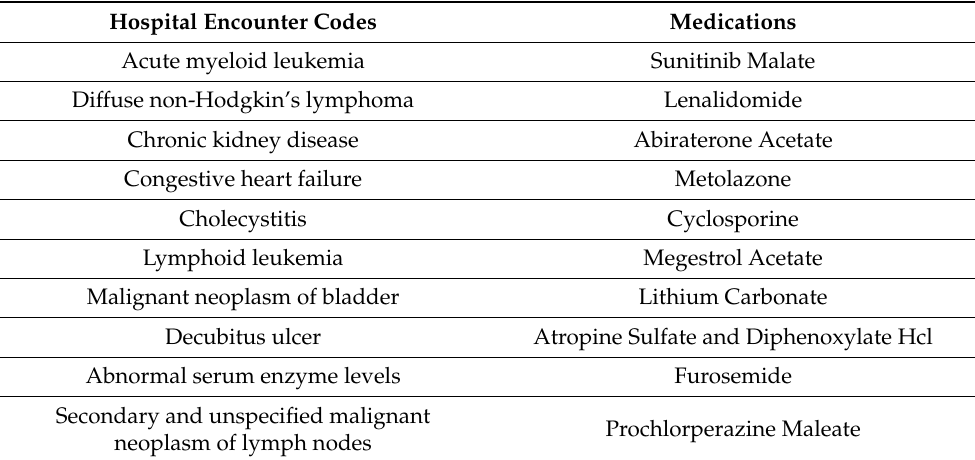
Table 2. The top ten features included in hospital encounter codes and medications